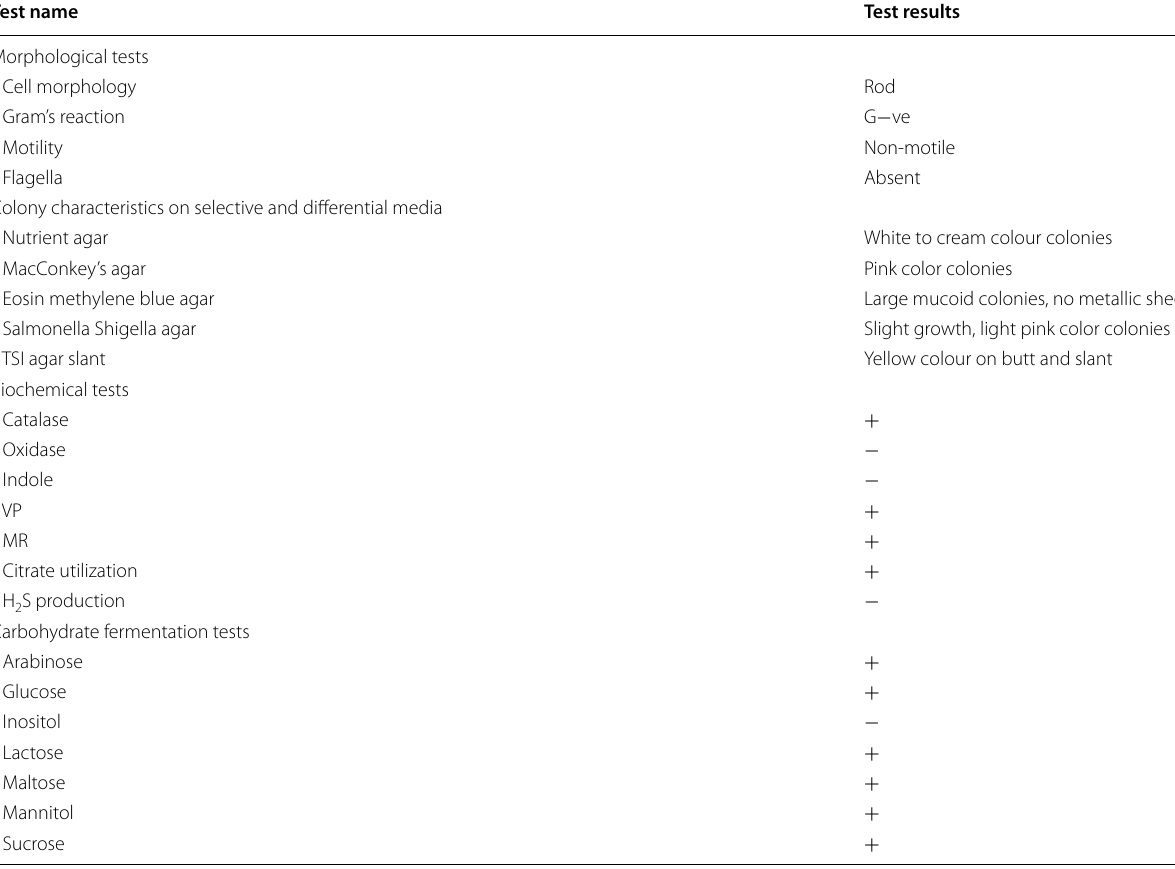
Plus Positive, Minus